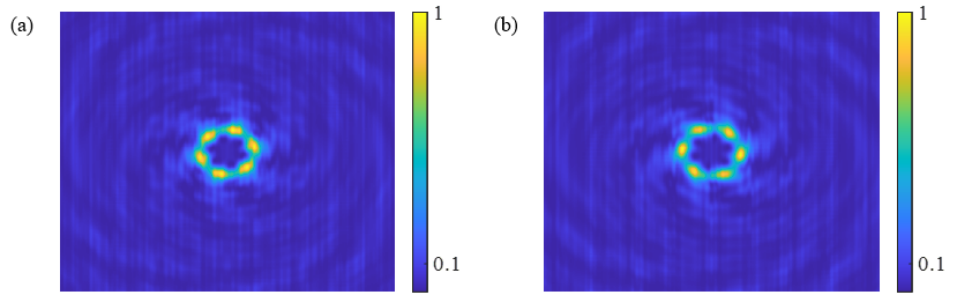
Figure 7. The simulated normalized diffraction patterns at the position of ( a ) z = 230 mm and ( b ) z = 270 mm.